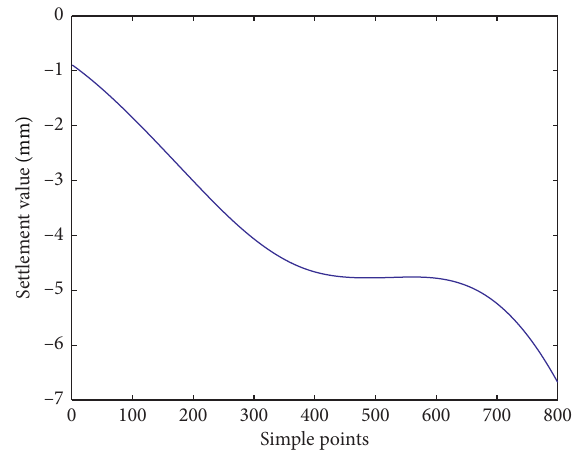
Figure 8: The fifth layer component.